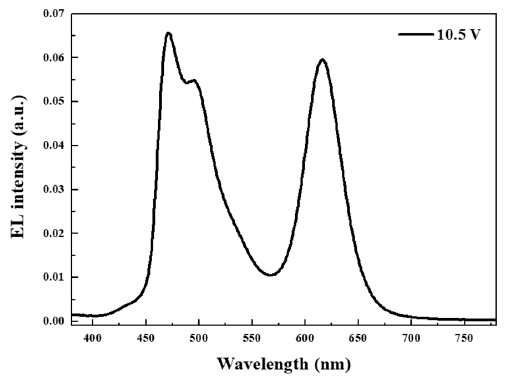
blue OLED devices (ITO/PEDOT:PSS/TFB/mCP:FIrpic/TPBi/LiF/Al) were separately fabricated to